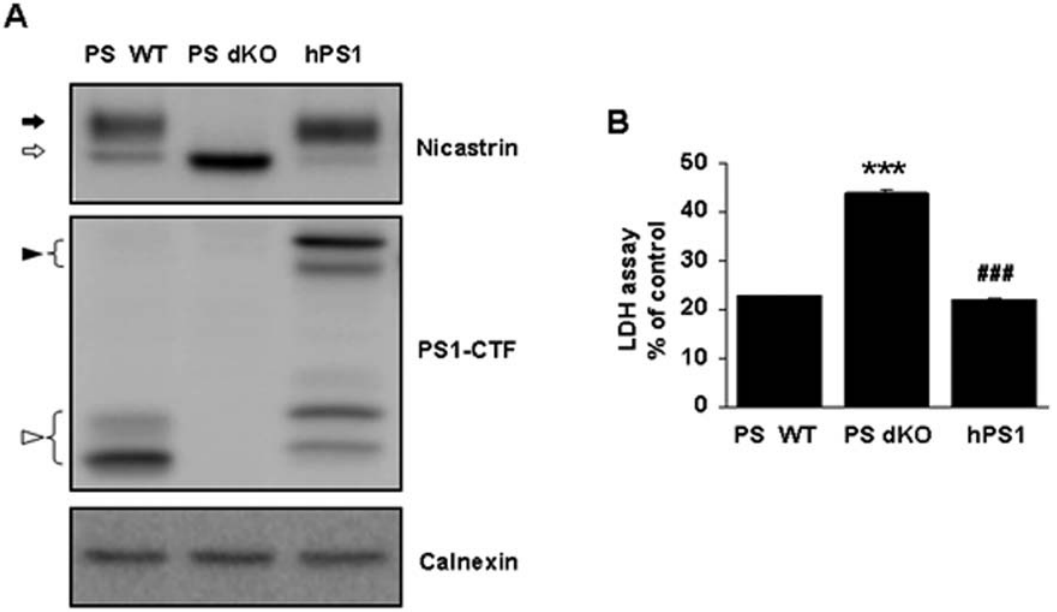
Figure 1. PS dKO MEFs are vulnerable to serum deprivation-induced cell death. (A) Western blot analysis of nicastrin and PS1 showing that PS dKO MEFs prevent nicastrin maturation. hPS1 MEFs were rescued PS1 and nicastrin maturation. Calnexin served as a loading control for membrane fractions. Filled and blank arrows indicate mature and immature nicastrin, respectively. Filled and blank arrowheads indicate full-length PS1 and PS1- CTF, respectively. (B) LDH release assay showing that PS dKO MEFs are injured by serum deprivation-induced stress. All MEFs were incubated DMEM media without serum for 36 hr. The graph represents (%) of positive control. Data are means 6 SEM values of three independent experiments. * represents significant differences from PS WT MEFs. ***P , 0.001. # represents significant differences from PS dKO MEFs. ### P , 0.001.